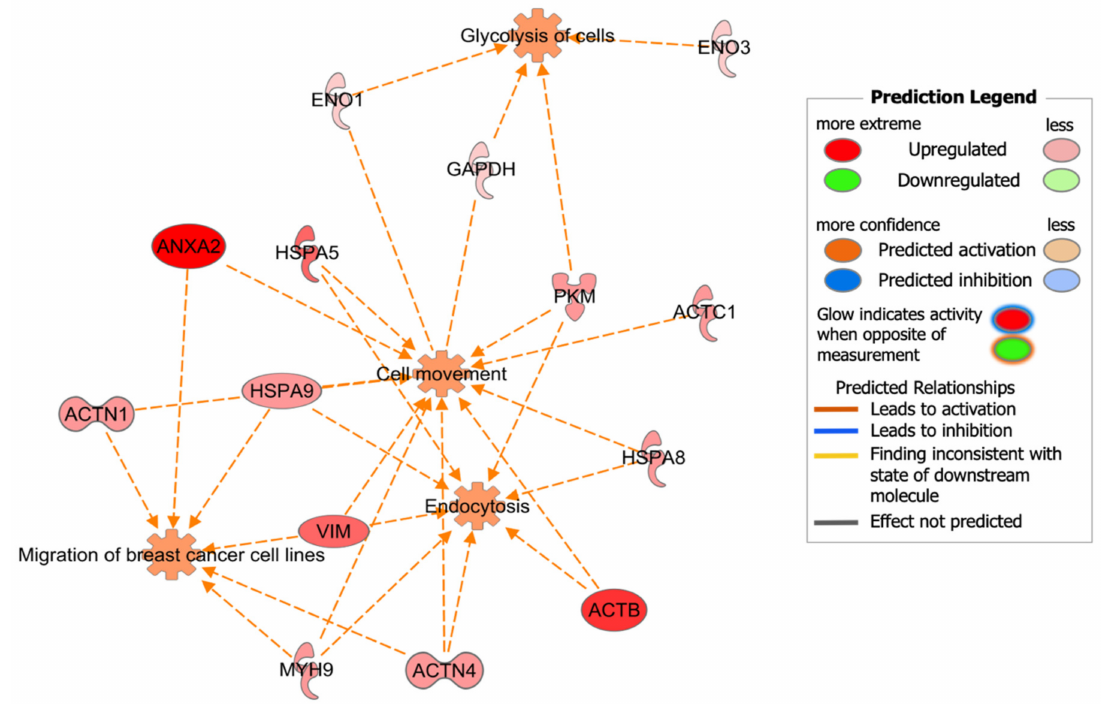
Figure 9. IPA graphical representation of the predicted biological functions linked to the top 7 canonical pathways affected by changes of proteins in response to the treatments of DOX-Ar-CC-NPs compared to DOX. The network is shown as nodes (proteins) and edges (represent biological relationships). Nodes in red indicate represent a high abundance of proteins. Various shapes of the nodes symbolise the functional group of the